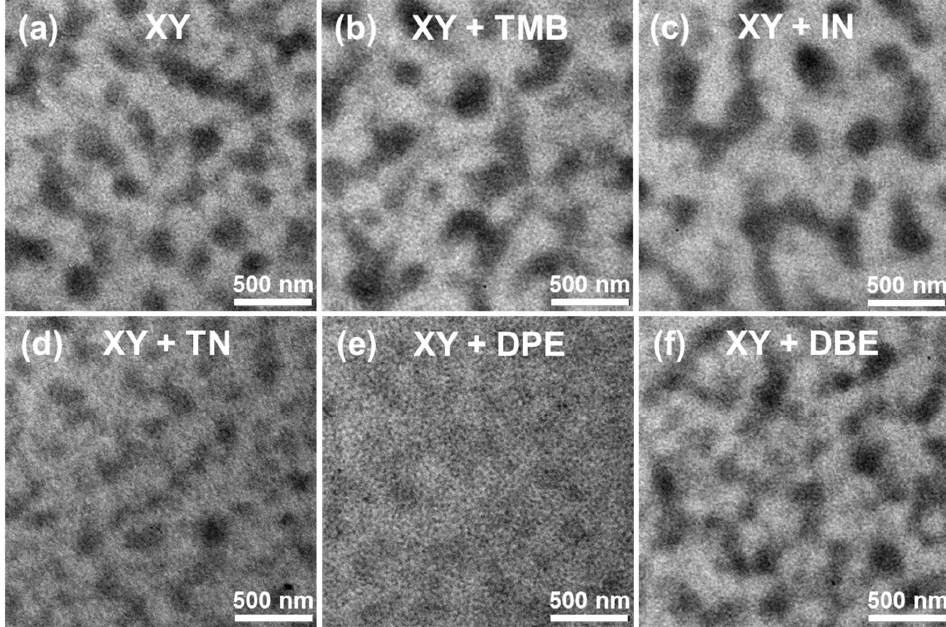
Figure 7. TEM images of ( a ) XY-, ( b ) XY + TMB-, ( c ) XY + IN-, ( d ) XY + TN-, ( e ) XY + DPE-, and ( f ) XY + DBE-based blend films.